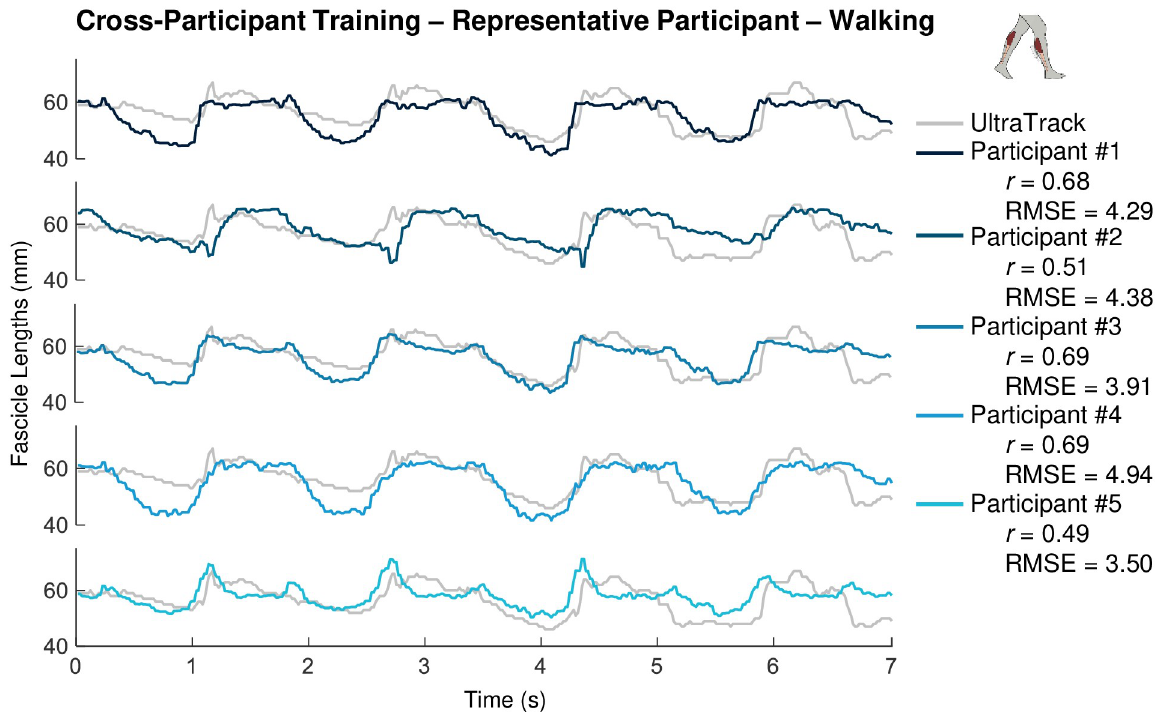
Fig 4. Muscle fascicle length versus time from optimized ML algorithm with cross-participant training in the walking task. Subplots show raw output of muscle fascicle length (mm) versus time (seconds) estimated using B-mode ultrasound images fed through a support vector machine (SVM) machine-learning (ML) model with optimized hyperparameters for a representative subject X during several cycles of the walking task. In each case, the SVM ML output was generated following a training procedure using image data from walking in each of the other participants (e.g., participant #1 = dark blue, participant #5 = light blue) and then used to measure muscle fascicle length in the test participant X (i.e., cross participant training). Muscle fascicle lengths derived from inputting the same B-mode images into UltraTrack (UT) software (gray) are included as ‘ground-truth’ to give context regarding correlation and RMSE across